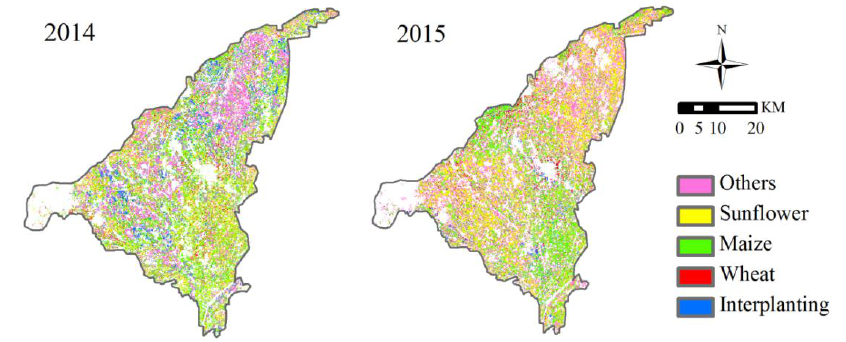
Figure 4. Spatial distribution of the main crops in 2014 and 2015. The groundwater level at the Jiefangzha Irrigation Field in March 2015, using the Kriging interpolation method [25], is shown in Figure 5. The southwest and part of